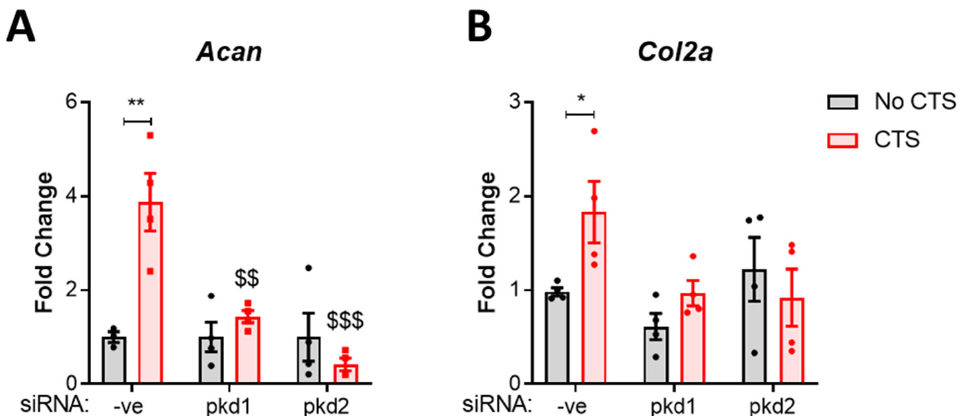
Figure 1. Polycystin-1 and polycystin-2 are required for the anabolic response to strain. Immortalized murine chondrocytes were treated with siRNA for pkd1 and pkd2 to deplete Polycystin-1 and Polycystin-2 expression and a negative control siRNA (-ve). Cells were subjected to 10% cyclic tensile strain (CTS) for 1 h at 0.33 Hz. Changes in gene expression for ( A ) aggrecan ( acan ) and ( B ) collagen type II ( col2a ) were quantified by qRT-PCR. Samples were normalized to GAPDH and expressed as a fold change relative to the -ve control (Statistics: two-way ANOVA with Tukey’s multiple comparisons test, n = 4). Significance is displayed relative to the no CTS -ve control as * = p < 0.05 and ** = p < 0.01, whereas $ denotes significance relative to the CTS -ve siRNA ctrl group where $$ = p < 0.01 and $$$ = p < 0.001.